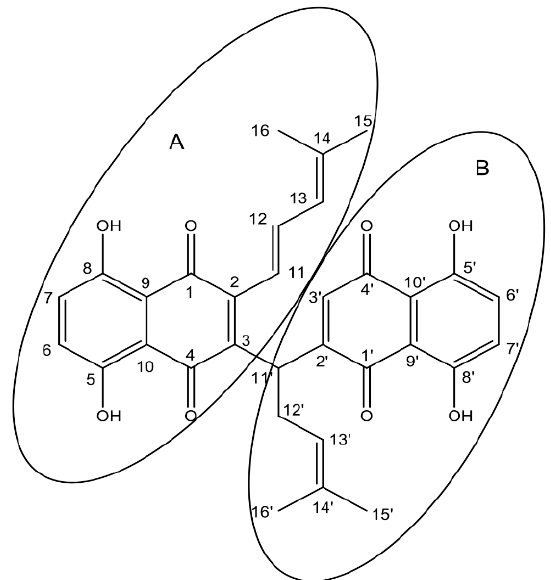
Figure 1. Structure of 1,4-dihydro-[2-(1-(1,4-dihydro-5,8-dihydroxy-1,4-dioxonaphthalen-3-yl)-4-methylpent-3-enyl)]-5,8-dihydroxy-3-(( E )-4-methylpenta-1,3-dienyl)naphthalene-1,4-dione (SK119). ( A , B ) indicate the shikonin-like moieties.